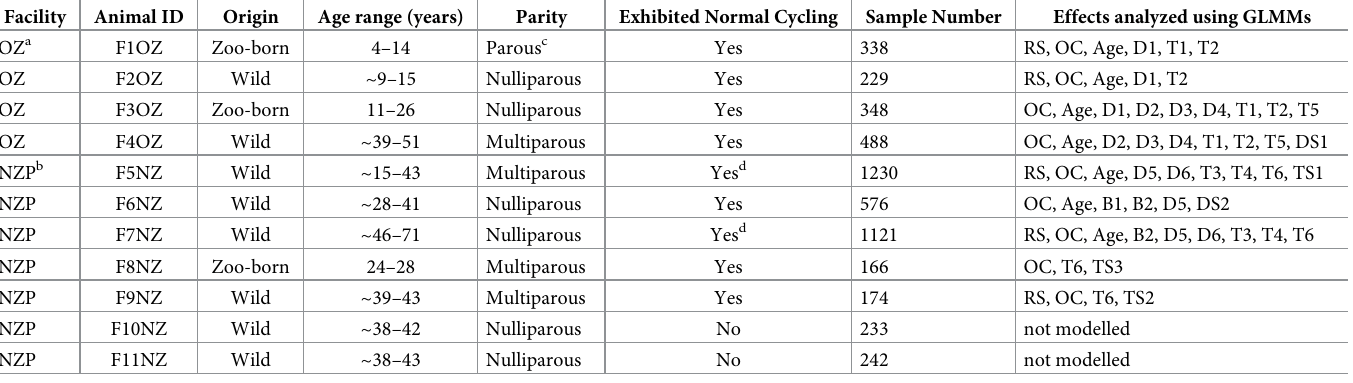
Table 1. Female elephants included in this study. Housing facility, individual, origin, age range during study, parity, whether the individual exhibited normal ovarian cyclicity during the study, number of samples analyzed, and statistical analyses performed for each